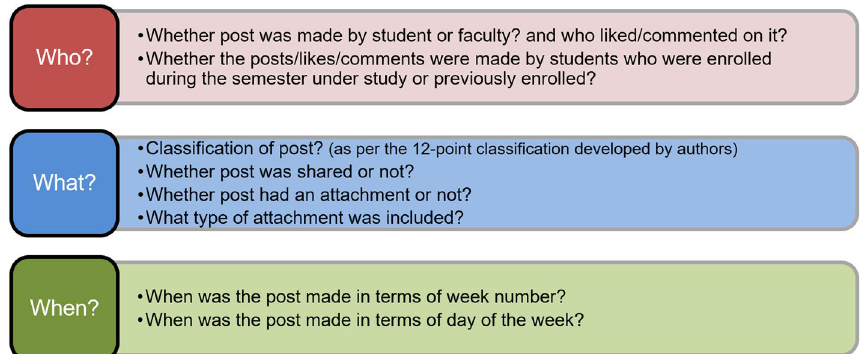
Fig. 1 The three main parameters focused on regarding the data collected for each of the 122 posts made on the group during the studied